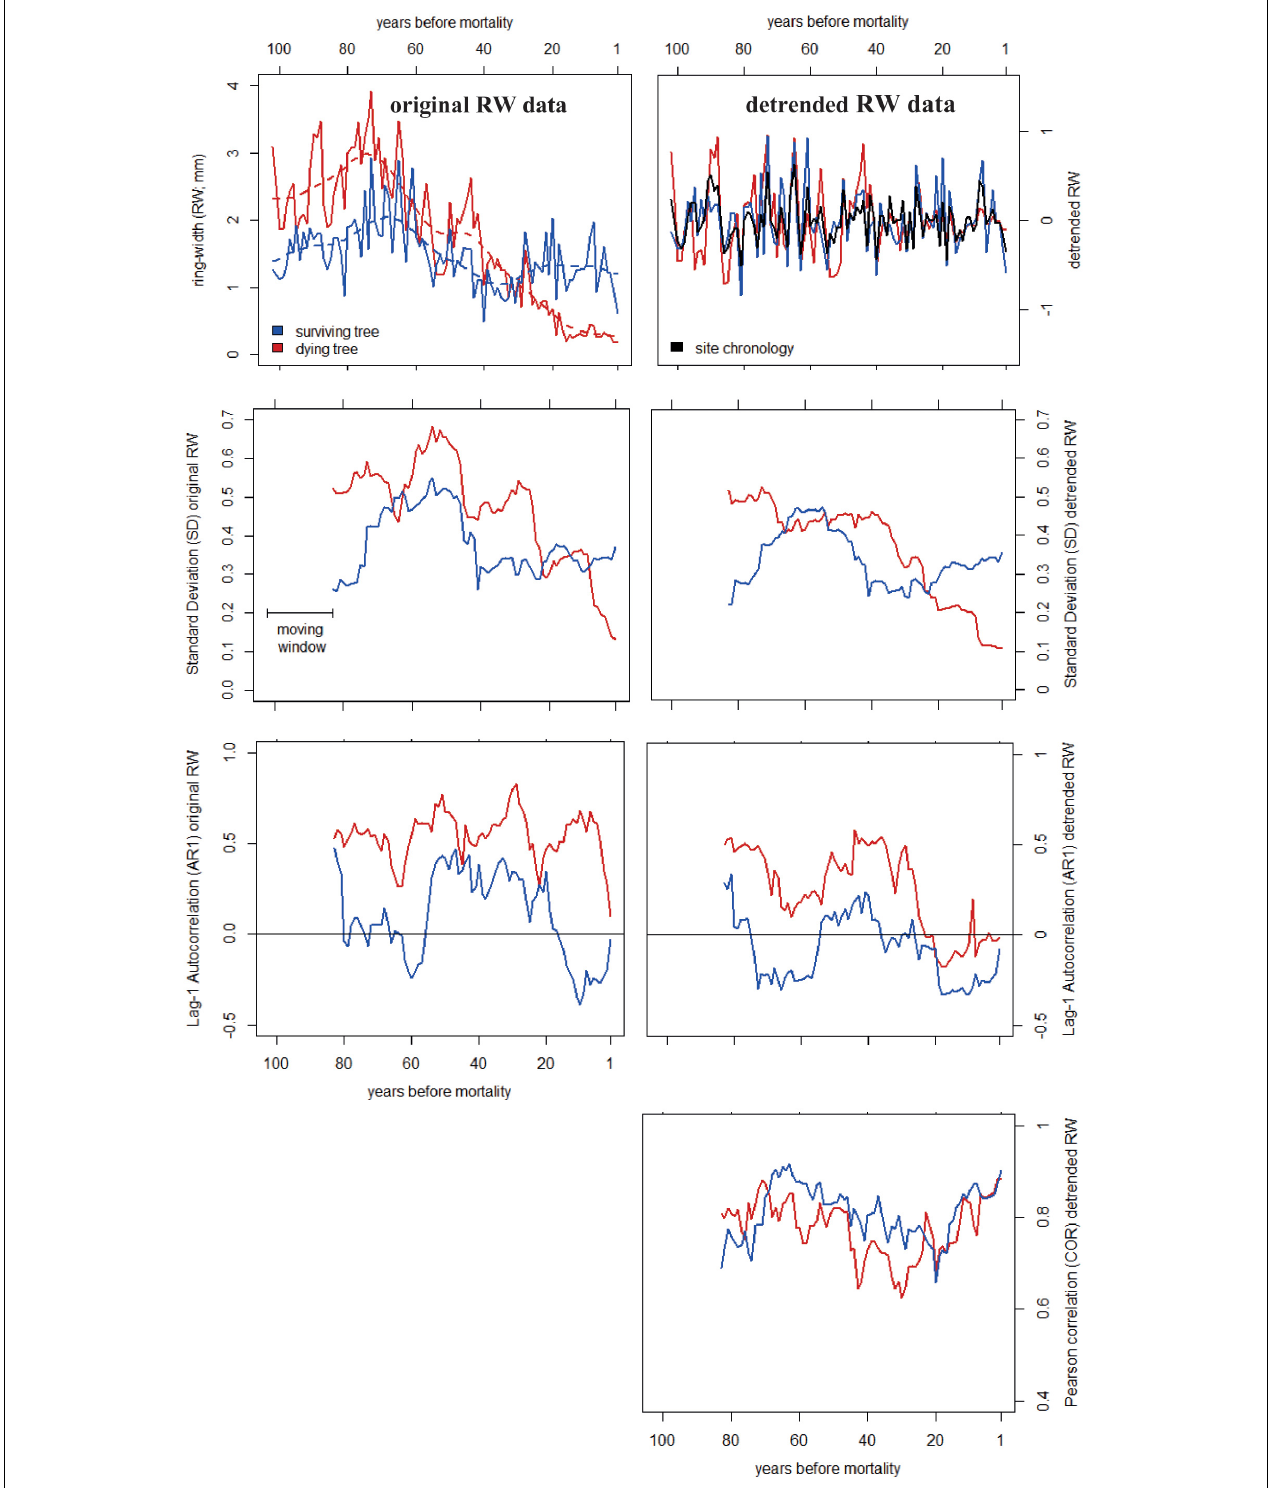
FIGURE 1 | Example of early-warning signals of tree mortality based on ring-width (RW) data from two Abies alba trees from Mont Ventoux, France (Cailleret et al., 2014). The Standard Deviation (SD), first-order autocorrelation (AR1) and Pearson correlation coefficients (COR) were calculated on the original ( Left ) and detrended ( Right ) RW data using 20-year moving time